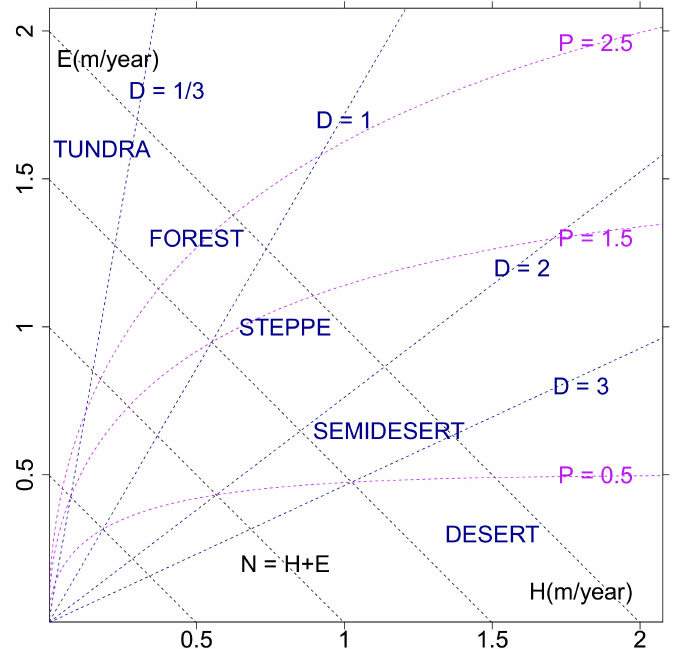
Figure 1. Ecohydrological state space (Stephenson’s diagram) spanned by evapotranspiration and sensible heatflux, E and H . Net radiation N , precipitation P , and the dryness ratio, D = N / P , are included employing the surface energy and water flux balance and the ecohydrological equation of state based on Budyko’s framework (units of fluxes in water equivalents of m / year; see text, Section 2).